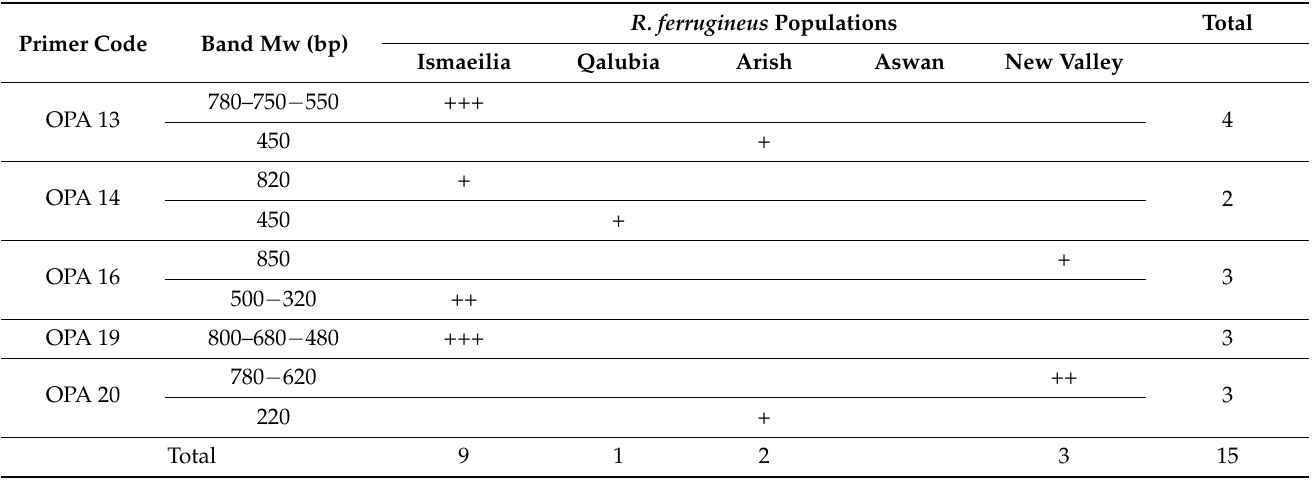
Table 4. Specific markers for R. ferrugineus populations across RAPD-PCR